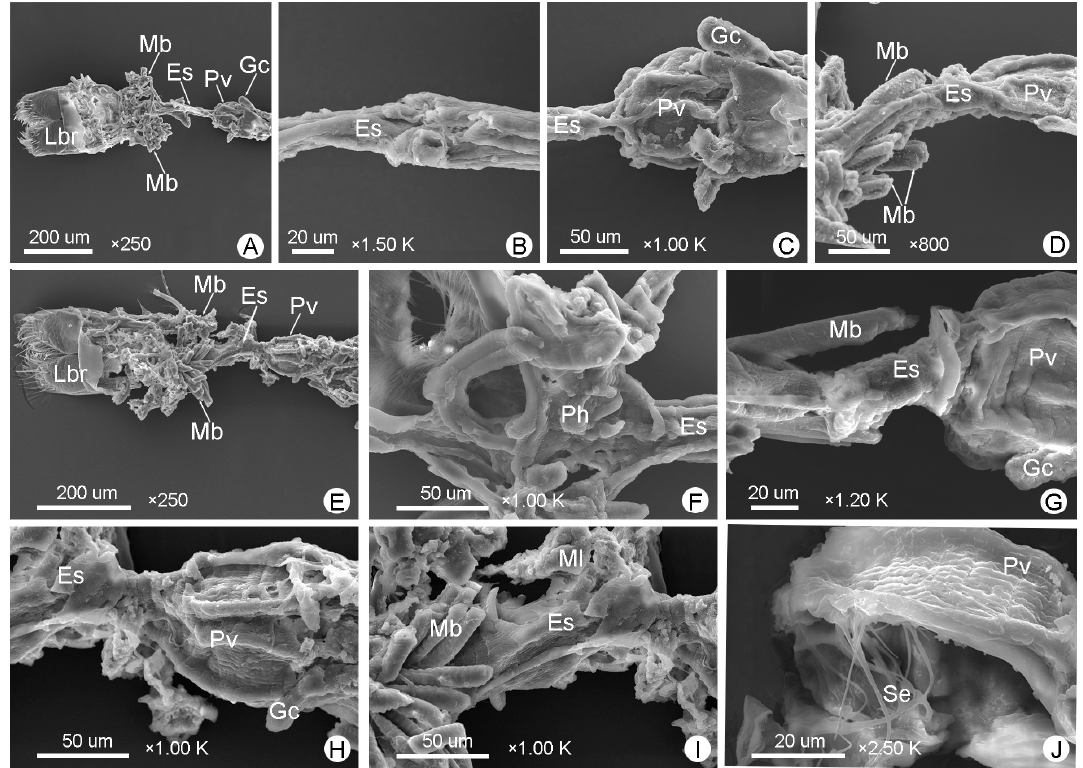
Figure 5. The foreguts of M . ( O .) chinensis (males ( A – D ), females ( E – J )): ( A , E ) general view of the foregut; ( B , G ) esophagus (Es); ( C , H ) proventriculus (Pv); ( D , I ) the muscle bundles (Mb) and muscle layer (Ml) around the foregut; ( F ) pharynx (Ph); ( J ) setae (Se) on the inner surface of the proventriculus. Gc: gastric cecum, Lbr: labrum. Table 1. The width (mm) (mean ± SE) of different organs in the alimentary canal of male and female M . ( O .) chinensis .